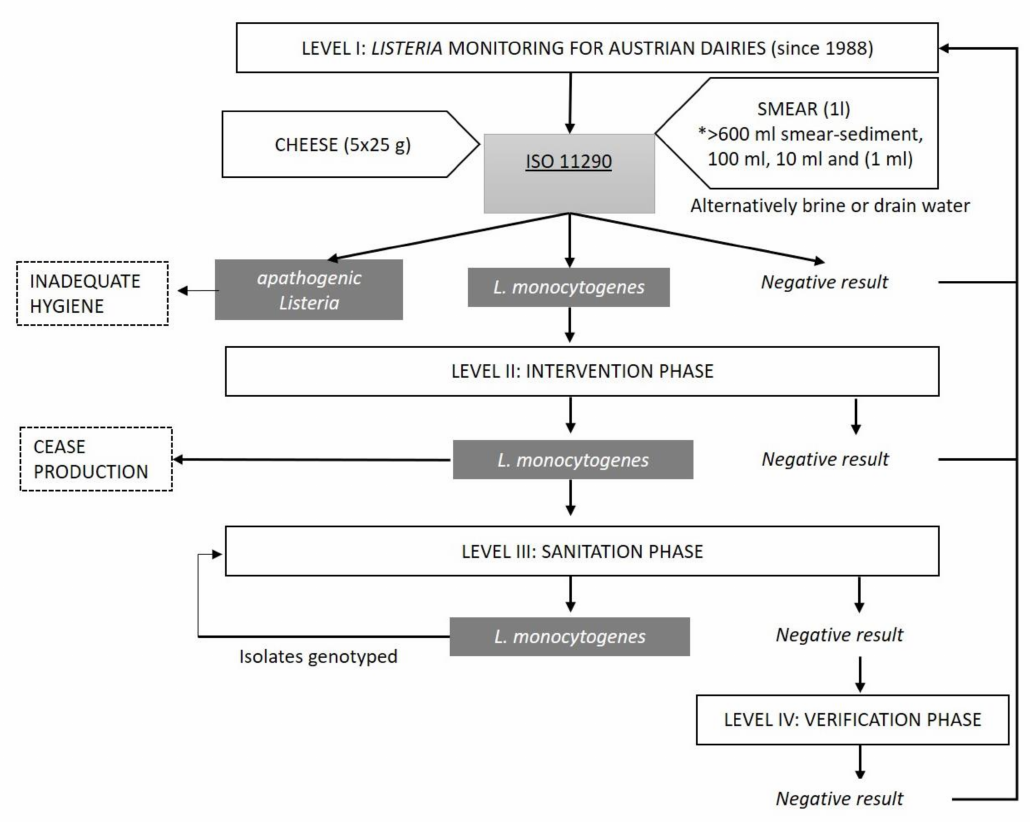
Figure 1. Flow chart displaying the structure of the Austrian Listeria monitoring and intervention program. Abbreviations: *, semi-quantitative liquid-based sample